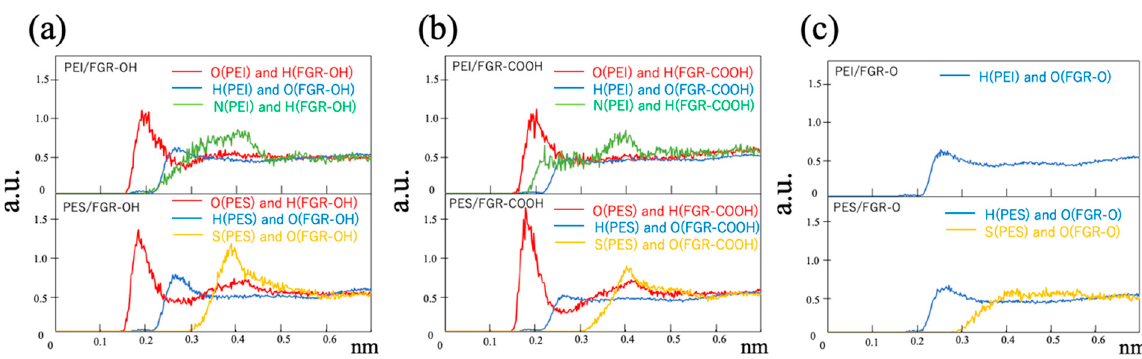
Figure 7. RDFs for atom pairs with positive and negative charge biases. ( a ) Functionalized graphene (FGR) modified with –OH, ( b ) FGR modified with –COOH, and ( c ) FGR modified with –O–. The upper and lower figures provide the corresponding data for PEI and PES, respectively.